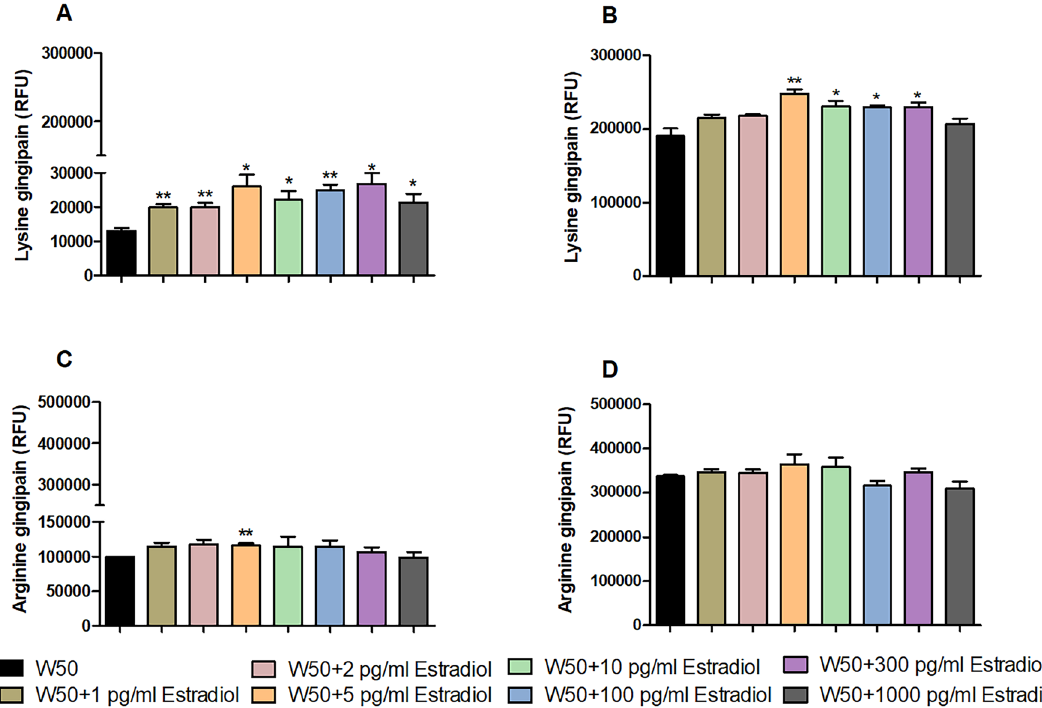
Figure 3. Estradiol increases the release of gingipains from P. gingivalis . P. gingivalis W50 lysine and arginine gingipain activity assay with or without the presence of estradiol (1 pg/ml, 2 pg/ml, 5 pg/ml, 10 pg/ml, 100 pg/ ml, 300 pg/ml and 1000 pg/ml,) during 24 h ( A , C ) and 72 h ( B , D ). Gingipain activity is measured using lysine and arginine gingipains substrate assay. Data are derived as relative fluorescence units (RFU) at 340/440 nm and presented as mean ± SEM of n = 3 independent experiments. The asterisk distinguishes statistical significance: *p < 0.05, **p < 0.01 vs. unstimulated P. gingivalis